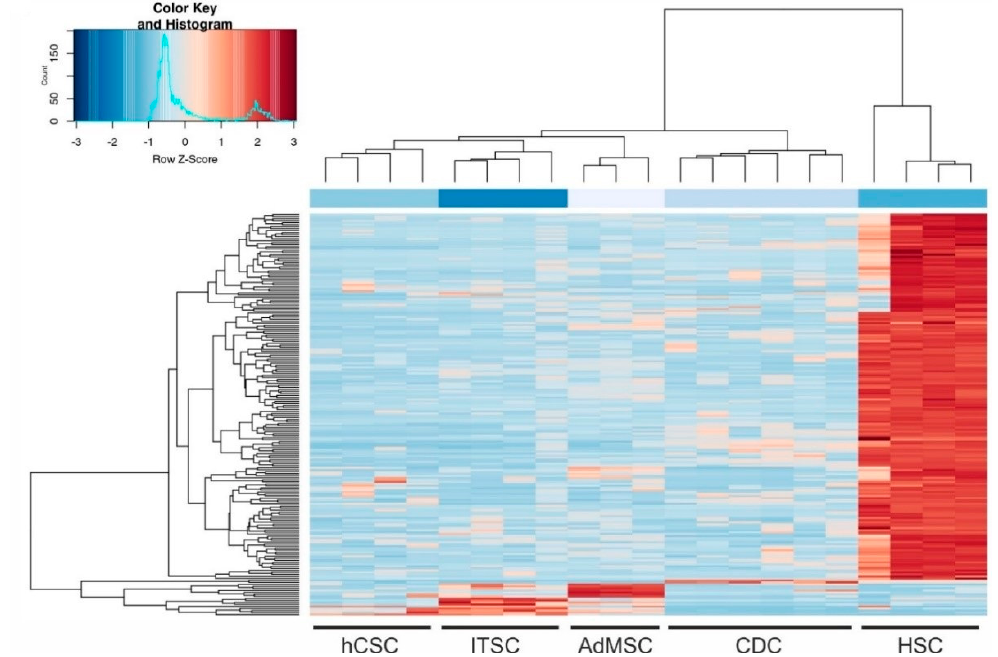
Figure 4. Hierarchically clustered heatmap of the 200 genes with the highest variance among all samples.